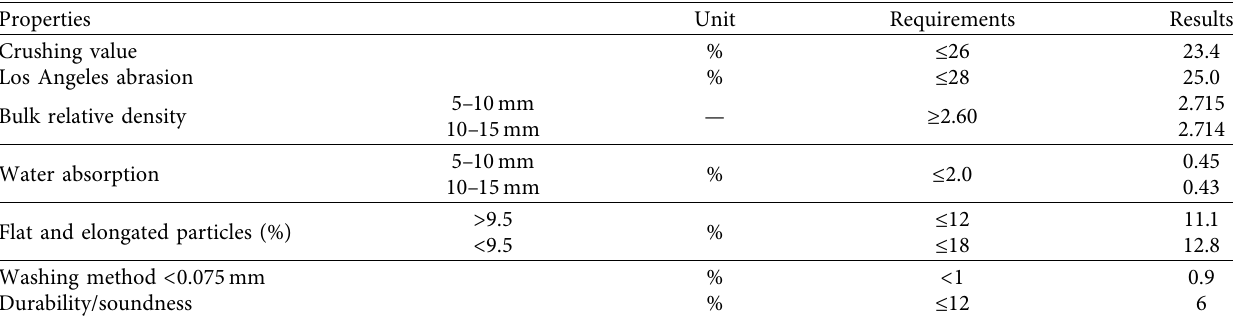
Figure 1: Flow chart of study materials and corresponding test methods. Table 1: Properties of coarse